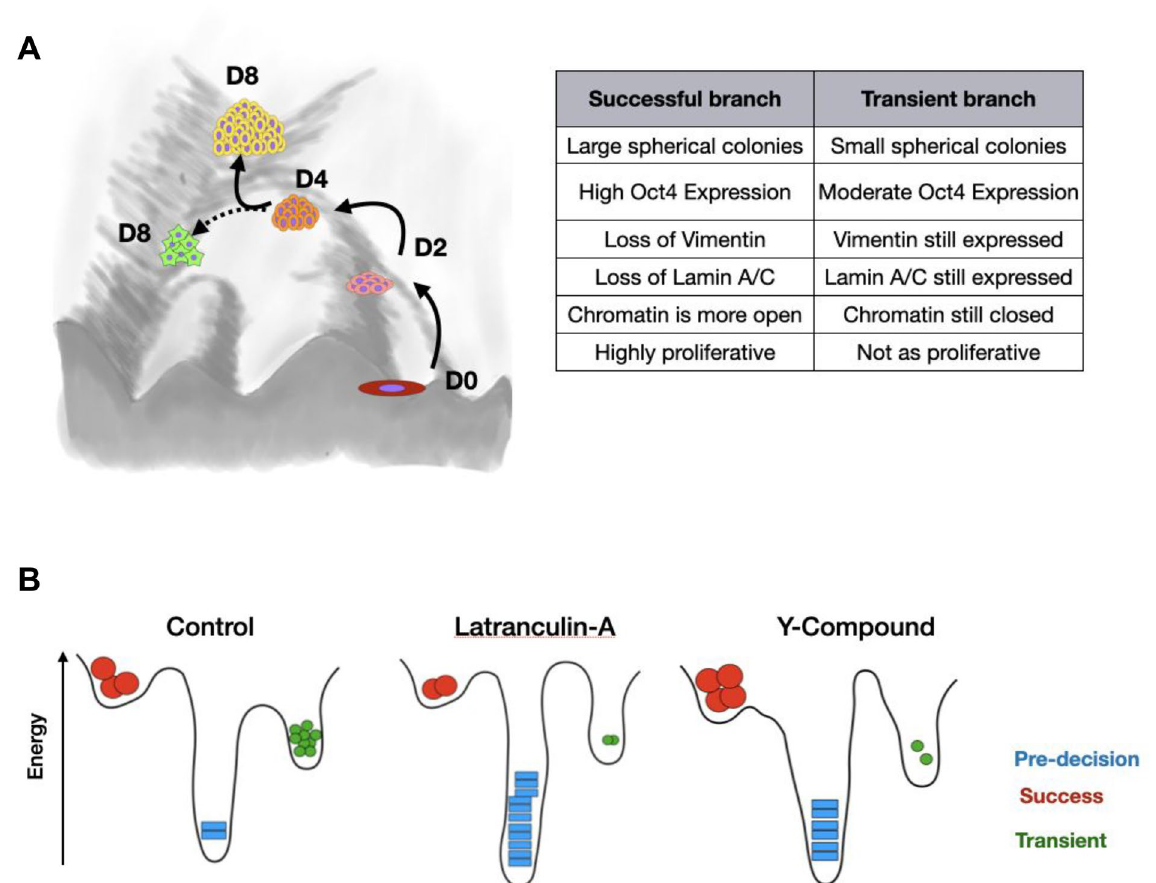
Figure 5. Graphical summary. ( A ) Graphical illustration of laterally confined growth induced cell state transitions: during laterally confined growth, a colony of cells metaphorically traverses through Waddington’s energy landscape. Two subpopulations were identified: a successful one with efficient cell state transitions and a transient branch with a mixture of cell states that are likely stuck in a local energy minima. The table on the right summarizes the key points of differences between the two trajectories. ( B ) The energy required to make certain cell state transitions can be modulated by the intrinsic cellular property of the actin cytoskeleton. Thereby enabling the direction of cellular decisions that occur during cell state